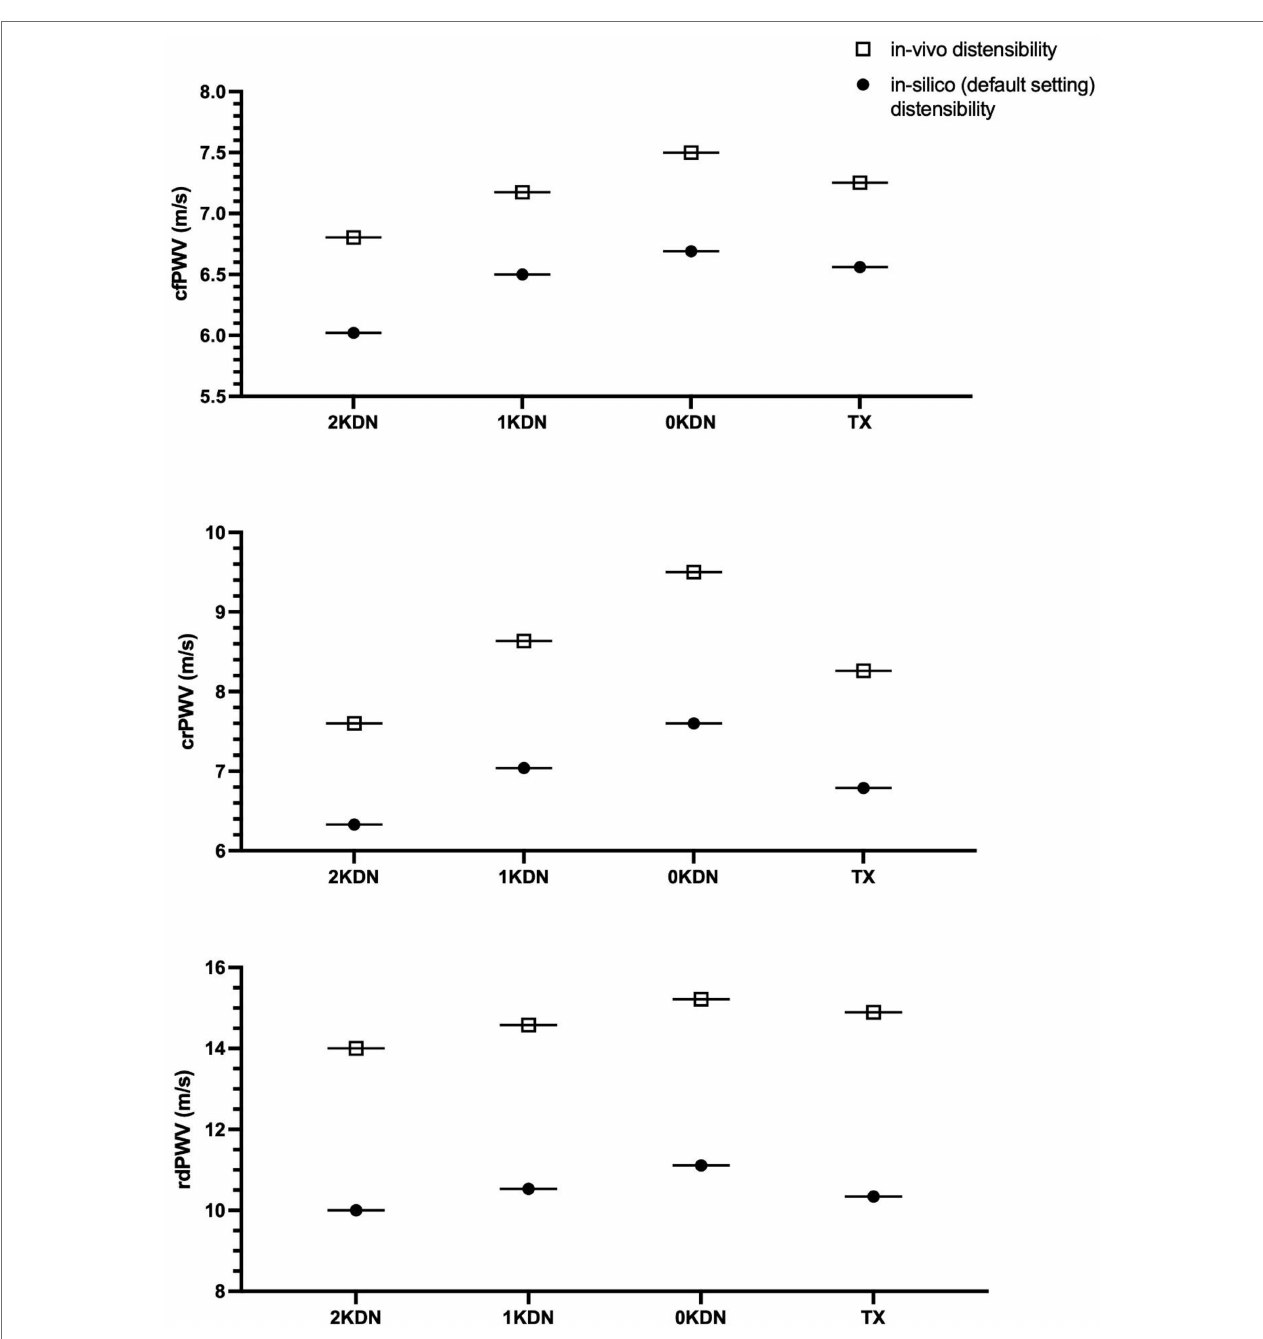
FIGURE 7 | Pulse wave velocity (PWV) results obtained with the literature in vivo distensibility data (0KDN) and the model default distensibility data ( in silico